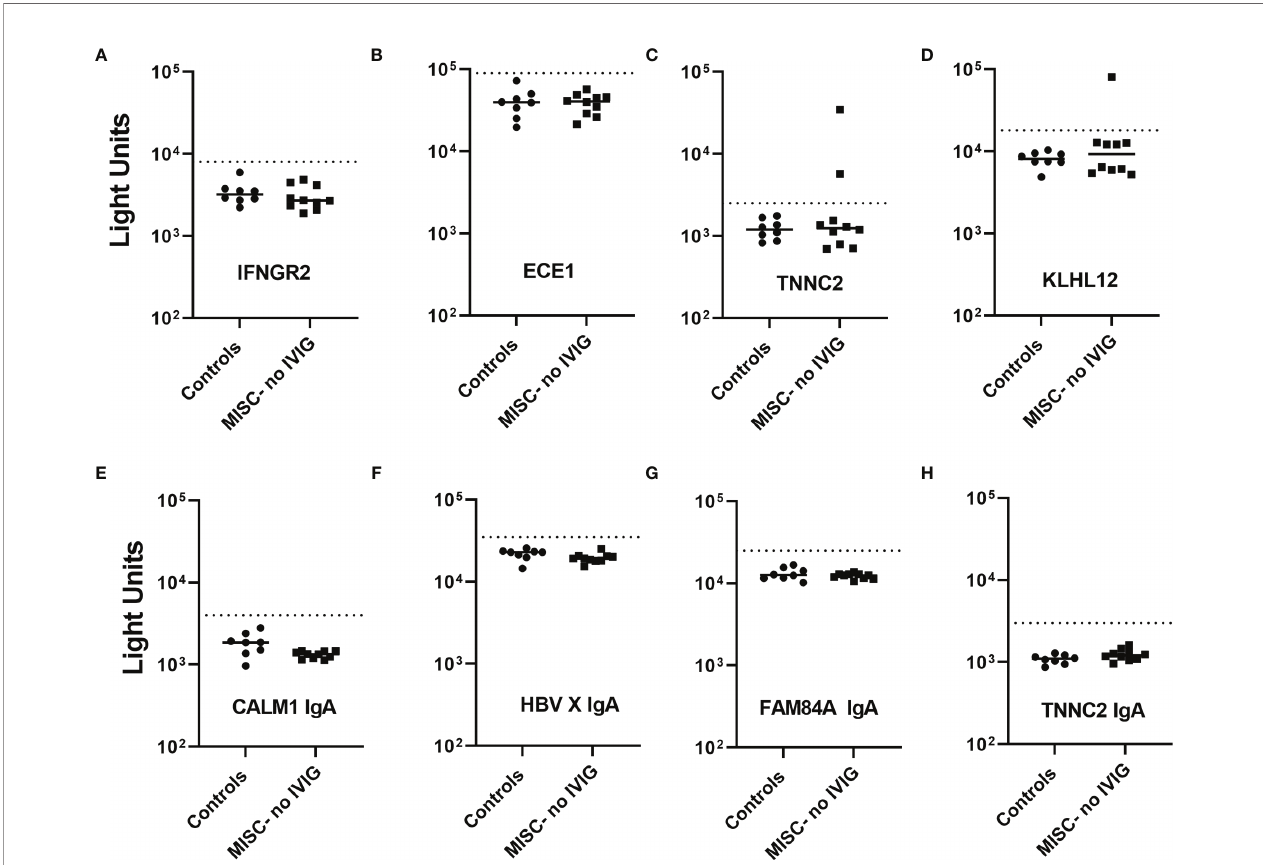
FIGURE 7 | Paucity of IgG and IgA autoantibodies to previously reported autoantigens in MIS-C. SARS-CoV2 uninfected children (controls) and MIS-C children who did not receive IVIG (MISC-no IVIG) were screened for IgG (A – D) and IgA (E – H) autoantibodies against potential target proteins discovered previously by autoantigen array studies. Autoantibody levels are plotted in light units on a log 10 scale. The dashed lines represent the cut-off level for determining positive antibody titers as described in the Methods. Only two antigens, TNNC2 and KLHL12 showed occasional IgG seropositivity in MIS-C and no seropositives IgA responses were